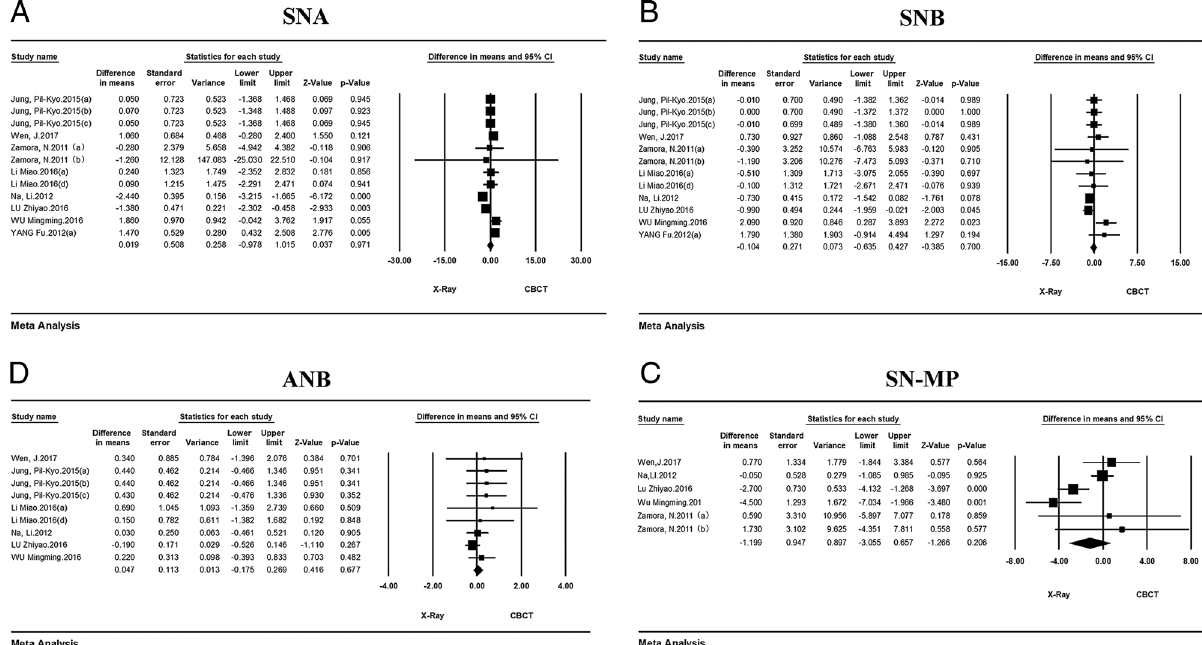
Figure 2. Forest plots of pooled DM for the CBCT group versus the X-ray group (A) SNA, (B) SNB, (C) ANB, (D)